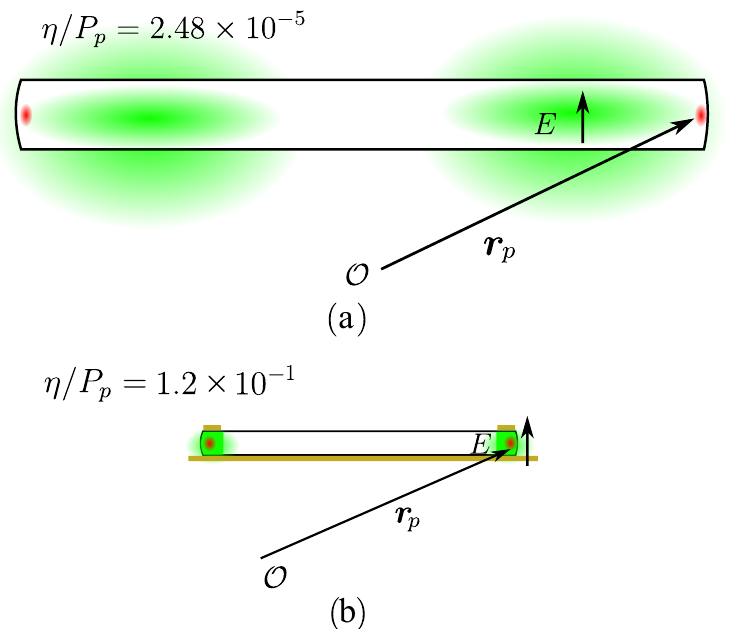
Figure 2. Comparison between millimeter-wave and optical modes for the following: ( a ) a disk resonator; ( b ) the proposed metal-enclosed resonator. Figures not drawn to